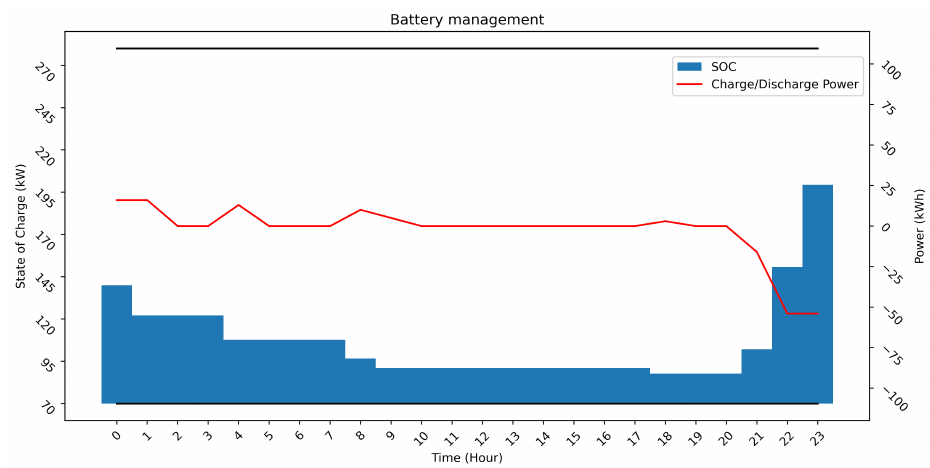
Figure 10. BESS management is based on MIP algorithm approach to case